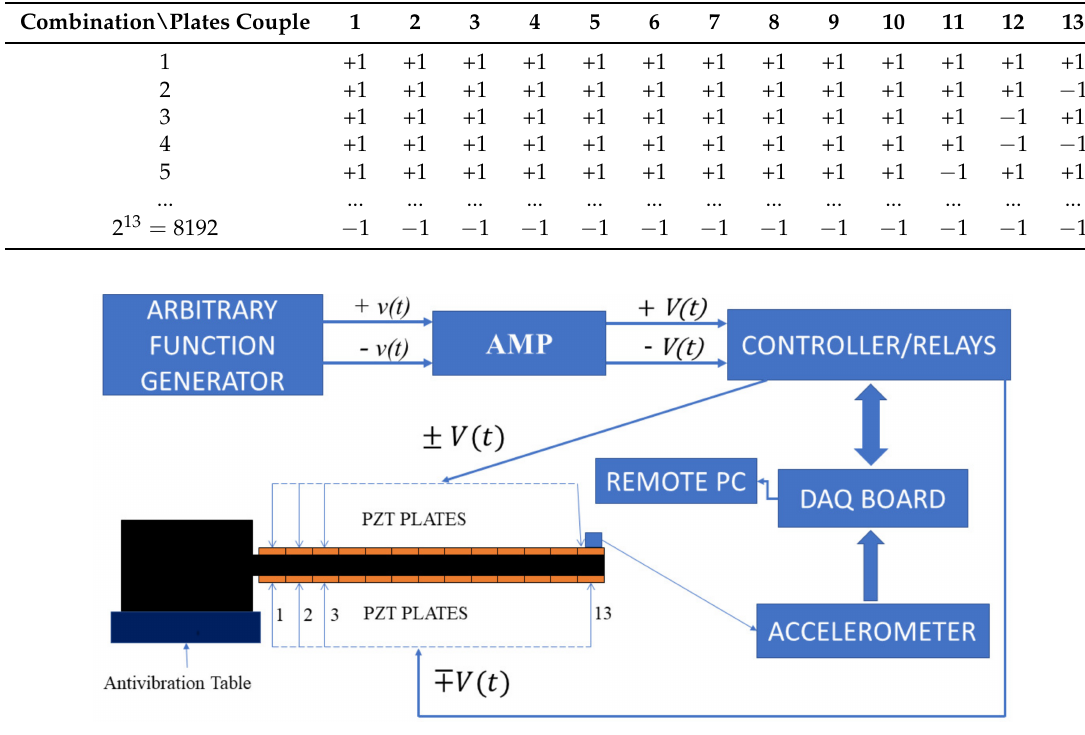
Figure 8. The authors’ amplifier circuit that drives the piezoelectric plates (the resistances are expressed in Ω ).